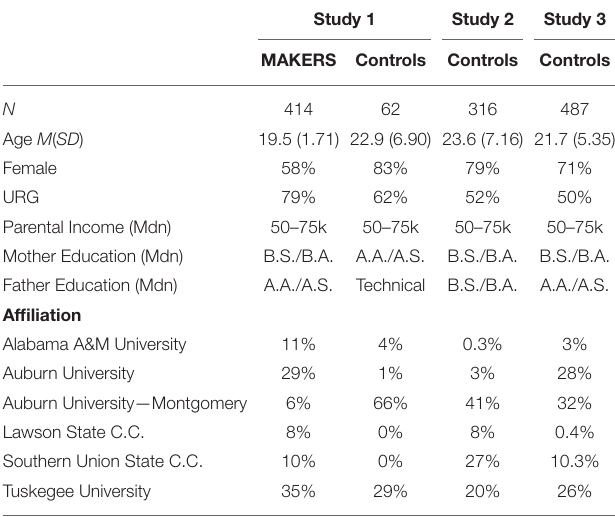
TABLE 1 | Descriptive statistics for scholar and control samples in studies